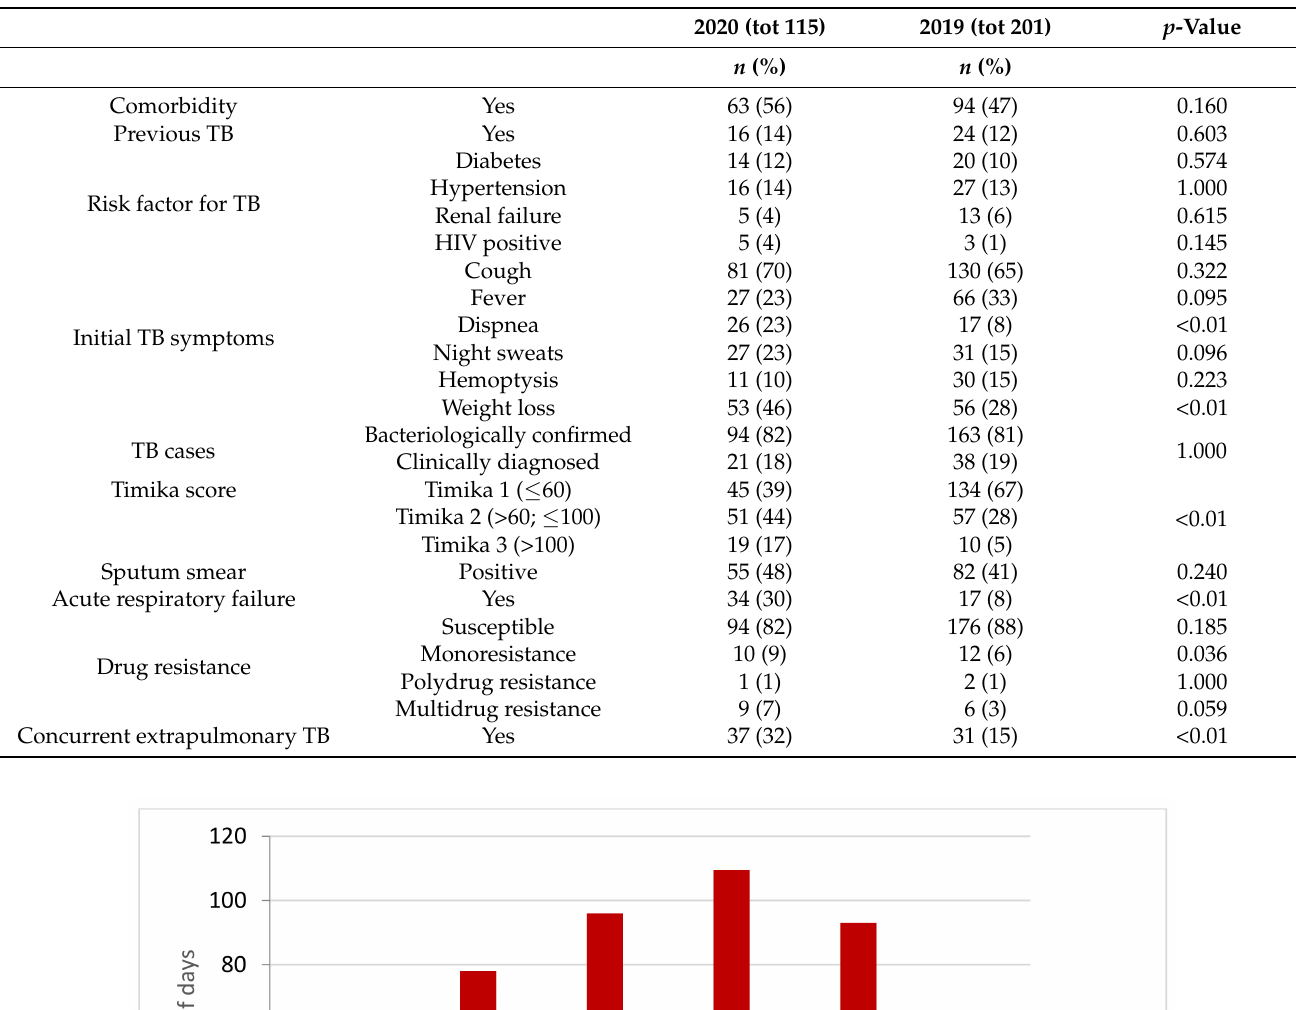
Table 2. Clinical characteristics.